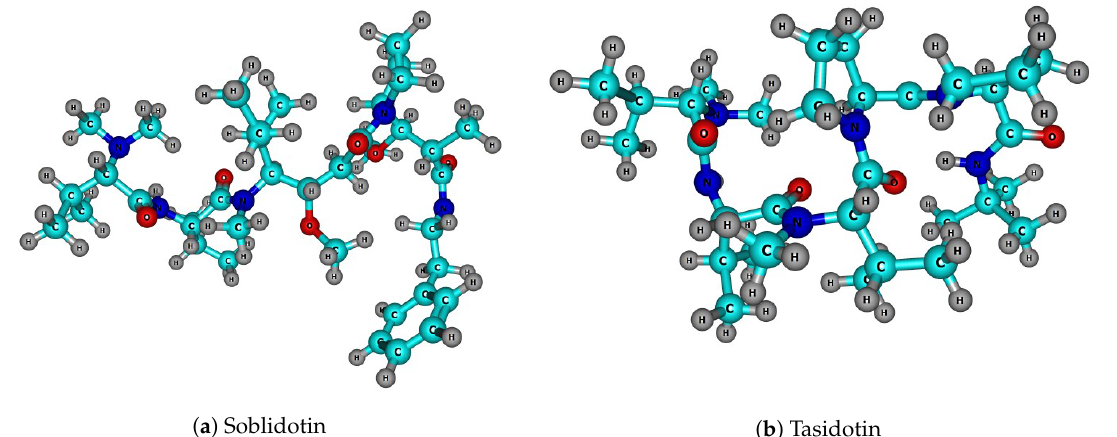
Figure 1. Graphical sketches of the molecular structures of the anticancer marine peptides: ( a ) Soblidotin and ( b ) Tasidotin. Table 1. Electronic energies of the neutral molecular systems (in au) of the anticancer marine peptides, Soblidotin and Tasidotin; the HOMO and LUMO orbital energies, as well as the HOMO–LUMO gap (in eV), and the maximum absorption wavelengths λ max (in nm).